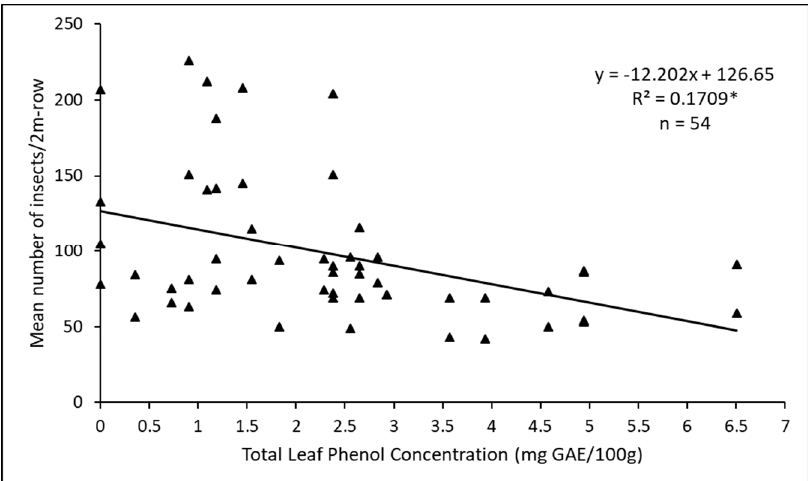
Figure 10. Regression line and equation showing the relationship between total leaf polyphenol content and D . glabrata population in 2018. * indicates significant regression coefficient at p < 0.05.